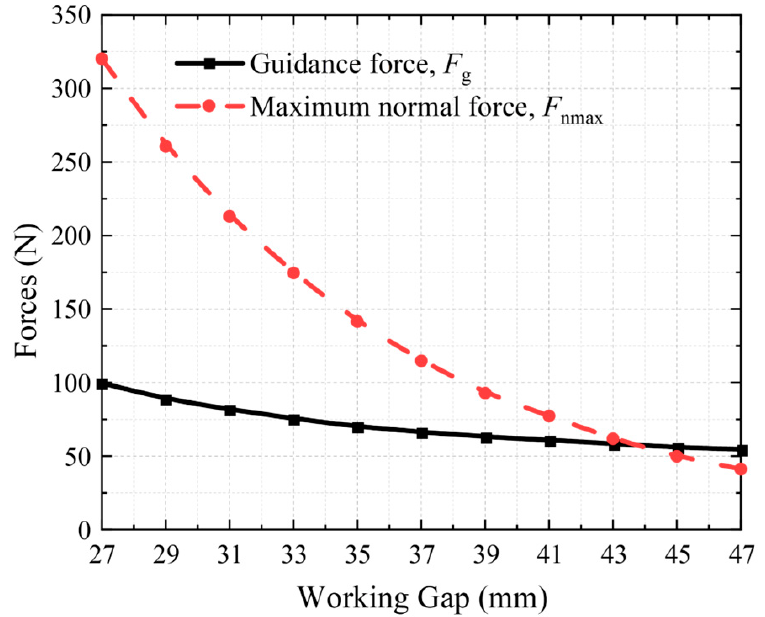
Figure 9. The guidance force and maximum normal force as functions of the working gap at a transverse speed of 2 m/s.